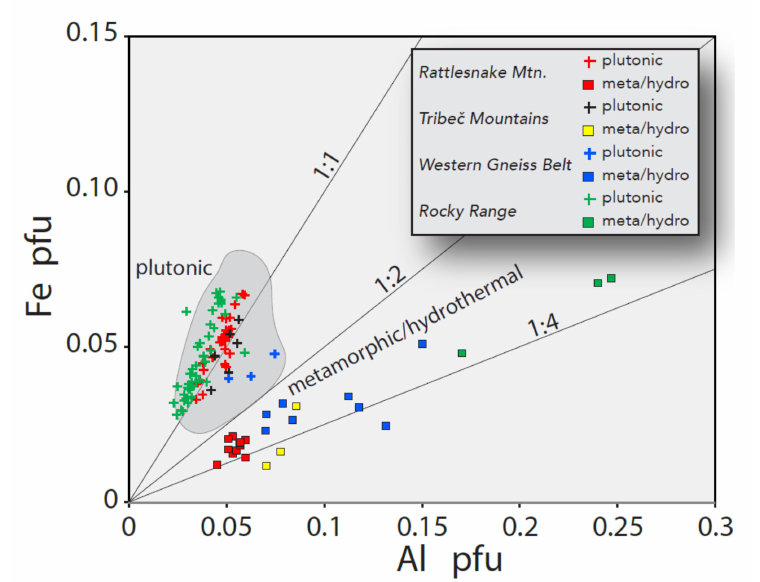
Figure 9. Fe versus Al for some plutonic titanites where overgrowths of secondary metamorphic or hydrothermal titanite have been identified. Overgrowths have low Fe and high Al. Data sources are Rattlesnake Mountain pluton (California, this paper); Tribeˇc Mountains granites (Slovakia [23]; Western Gneiss Region, (Norway [109]), and Rocky Range pluton (Utah, this paper).